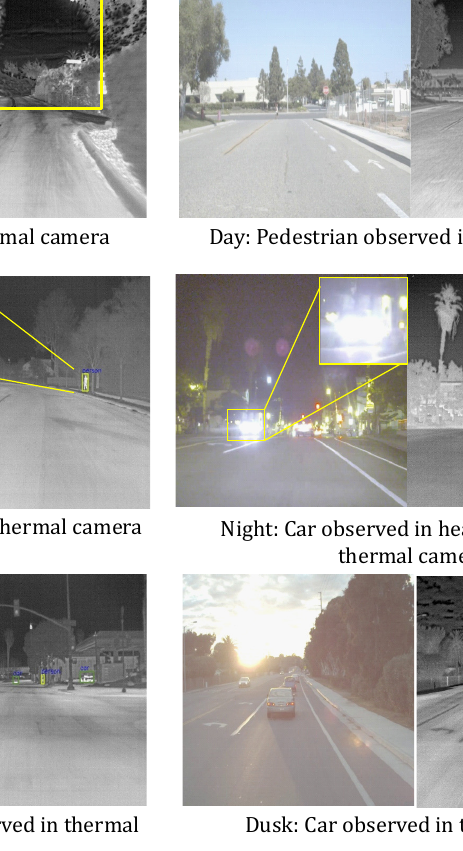
Figure 2. Scenes from the FLIR dataset, where thermal camera images are compared with visible camera